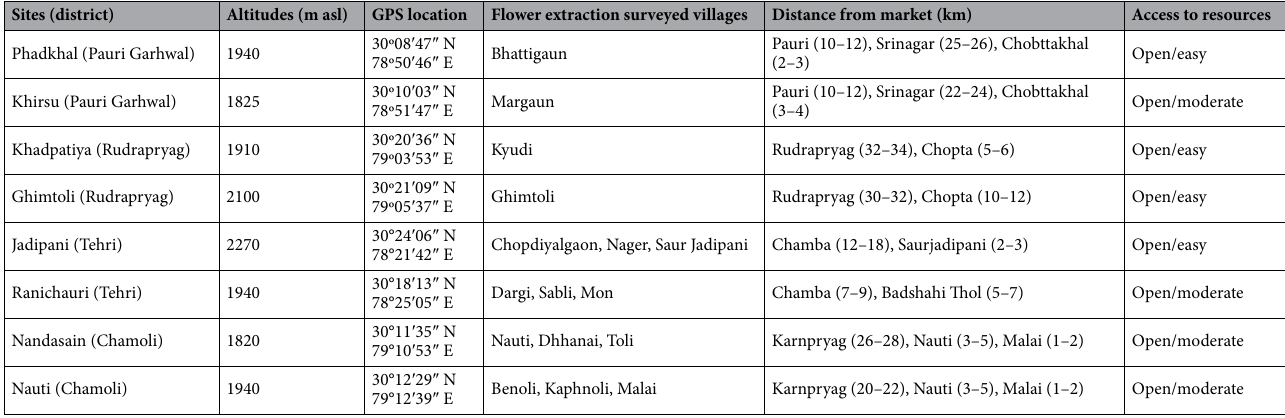
Table 1. Physical characteristics of study sites in four districts of Garhwal